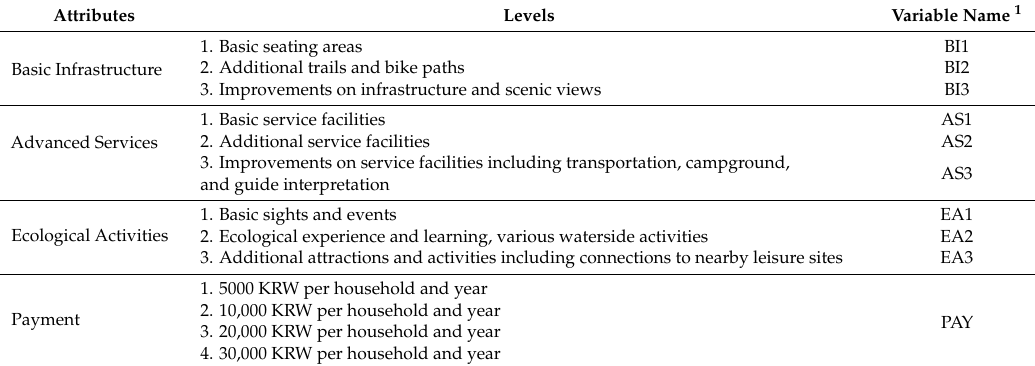
Table 2. The attributes and levels for choice